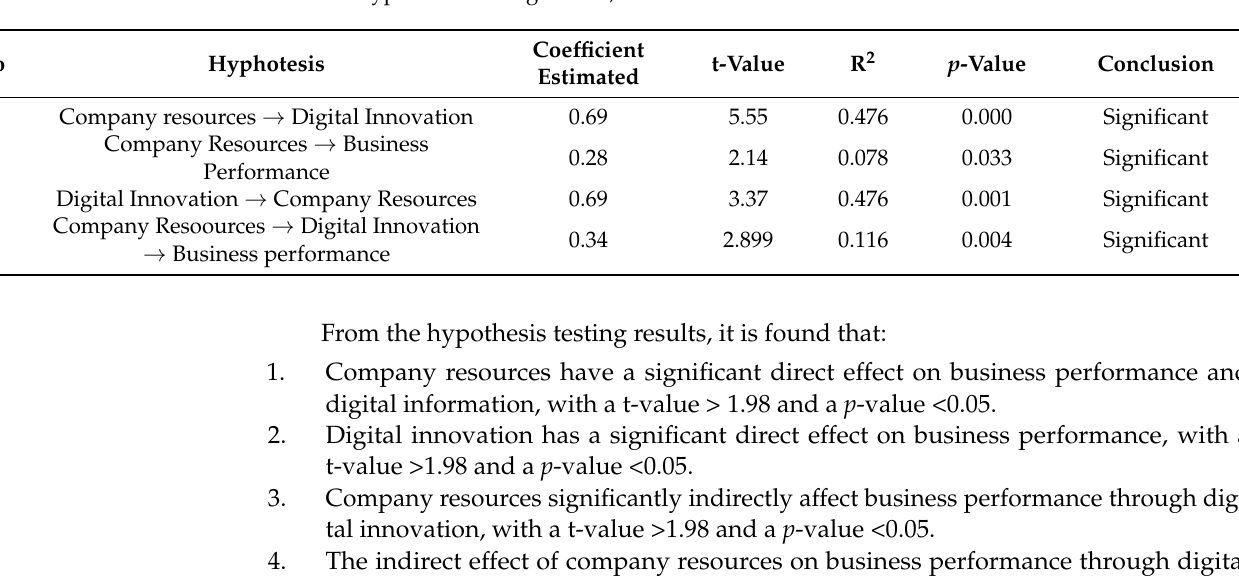
Table 5. Hypothesis testing results, Source: